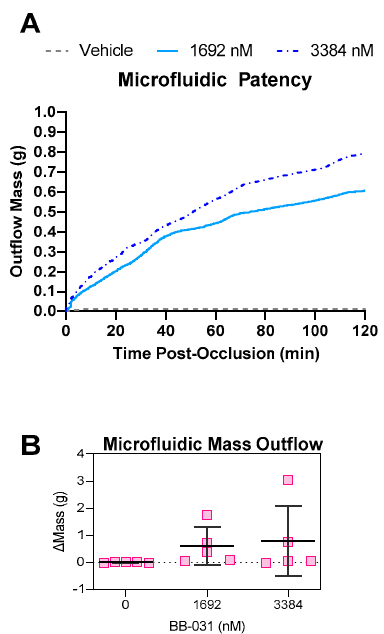
5 of 14 Figure 4. Microfluidic reperfusion experiments. ( A ): I. Partial occlusion is induced in a controlled flow setting in a microfluidic stenosis (initial wall shear rate at the throat 3500 s − 1 ; target pressure increase 25 mmHg). Platelets in this sample are labelled aqua (PLT throm ). II. Reperfusion is initiated with a treated sample using the syringe pump and low flow. Once the treated sample reaches the